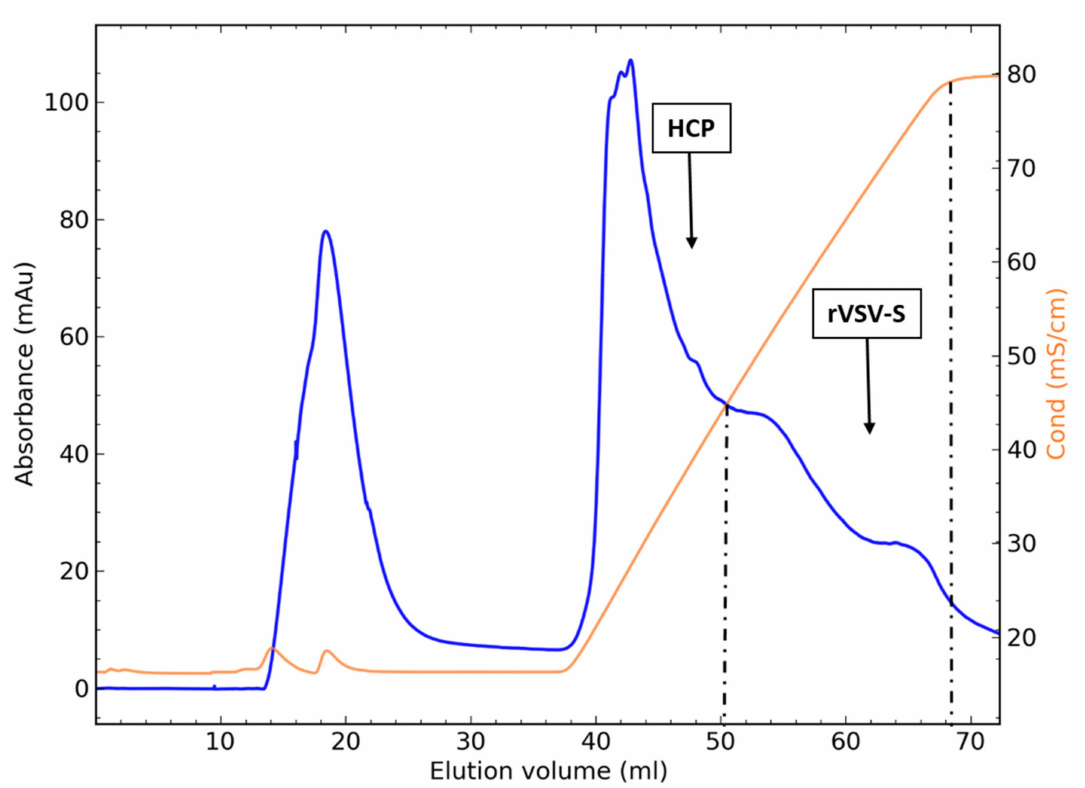
Figure 1. Chromatogram of rVSV-S purification on a Q-XL ion exchanger with 150 mM NaCl. HCPs are eluted up to 45 ms/cm, and the virus is eluted between 45 and 80 ms/cm. Table 2. Purification of rVSV-S on a 1 mL Q-XL anion exchanger with 150 mM NaCl. Fractions